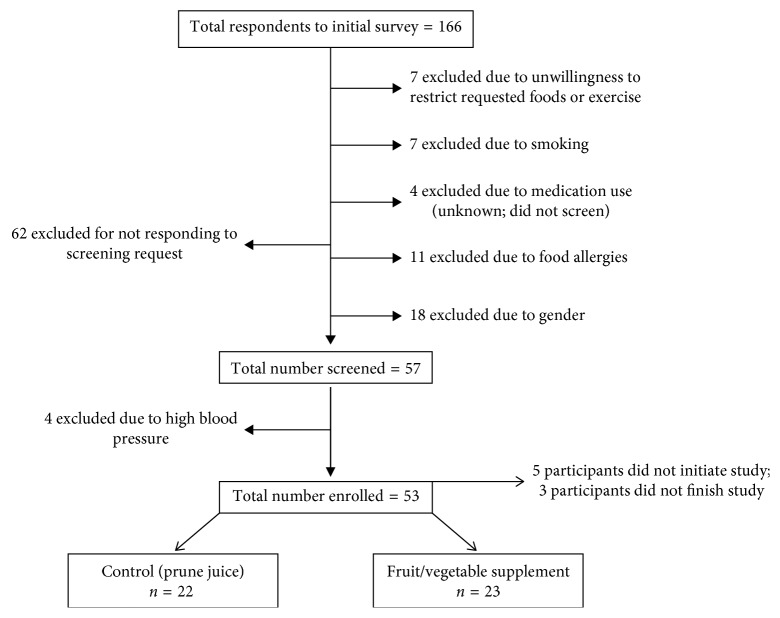
Consort diagram.